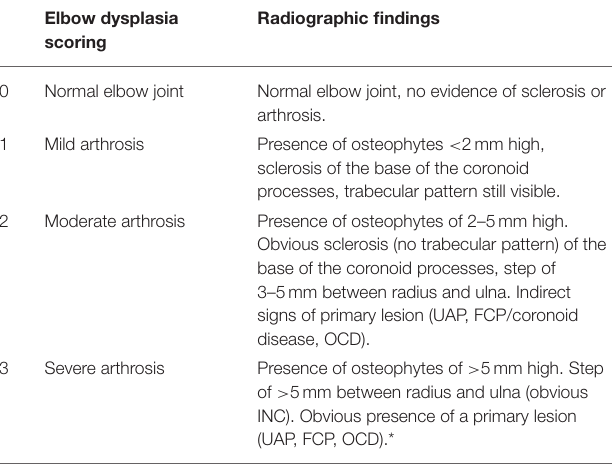
TABLE 1 | Elbow scoring modified from the International Elbow Working Group (IEWG) 2012 ( 15). Elbow dysplasia Radiographic scoring